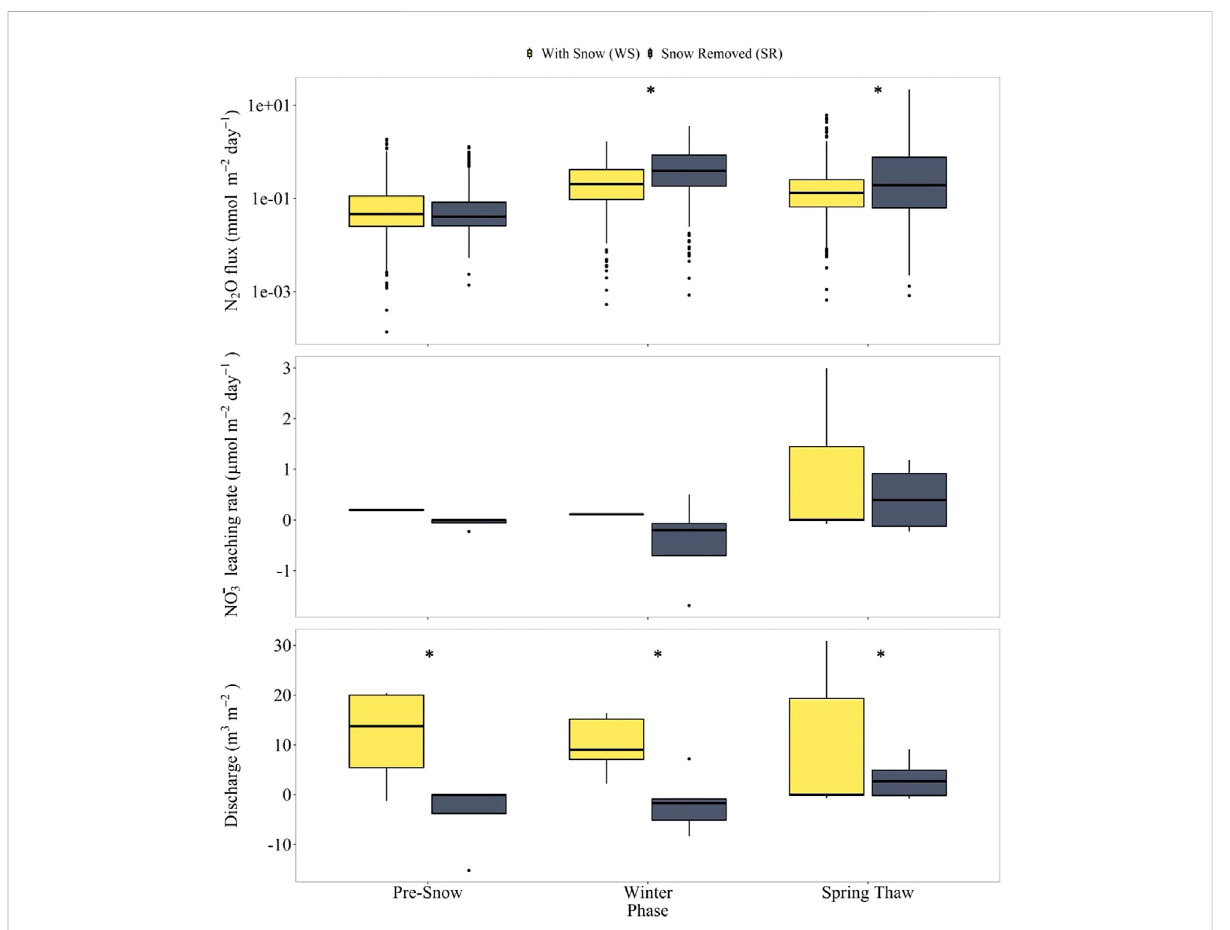
FIGURE 5 Box plots of N 2 O fl uxes (top panels), NO 3 − leaching rates (middle panels), and discharge rates (bottom panels) in silt loam lysimeters SL-SR and SL-WS during the pre-snow, winter with/without snow, and spring-thaw phases. The y -axis for the N 2 O fl uxes is a log-axis (top panel only). An * above the boxplots signi fi es median valuesthat are statistically signi fi cant between theSR and WS lysimeters. Values are statistically signi fi cant when p ≤